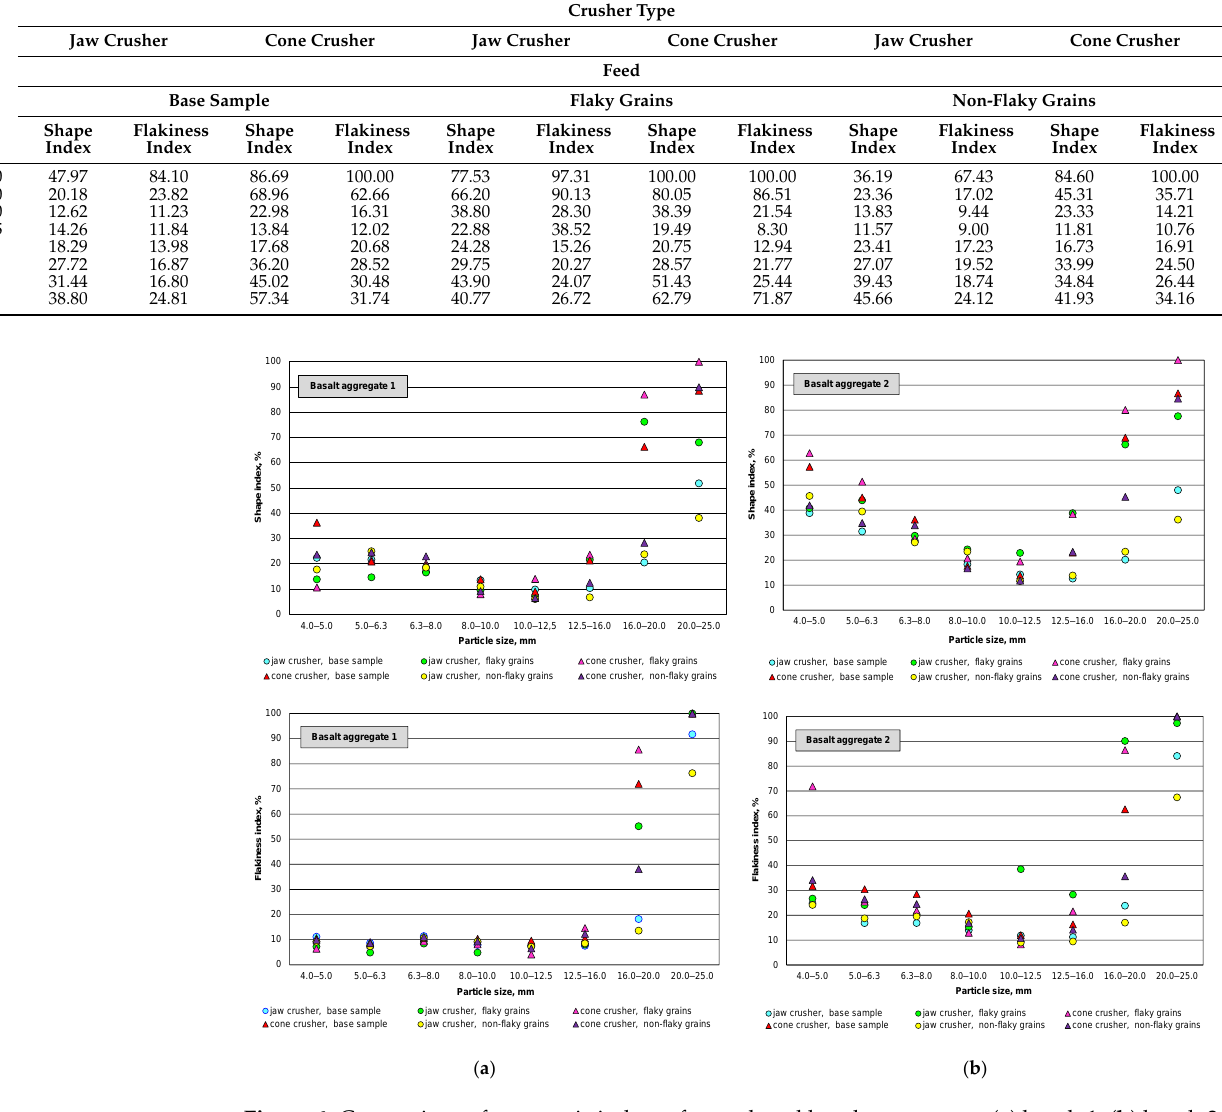
Table 4. Average shape and flakiness indexes for the analyzed basalt aggregate 2 after crushing.